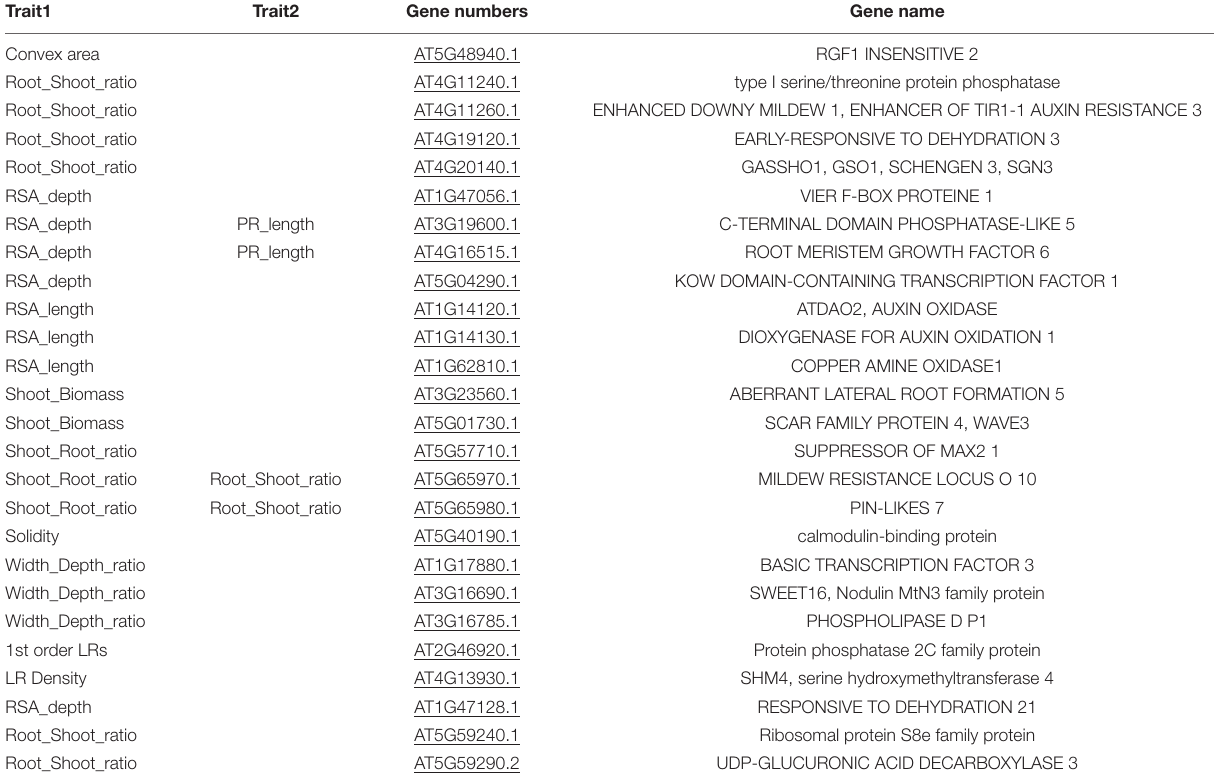
TABLE 5 | List of 26 genes selected based on their ontologies as genes of interest, together with information from which traits where those genes detected by QTCAT analysis. Trait1